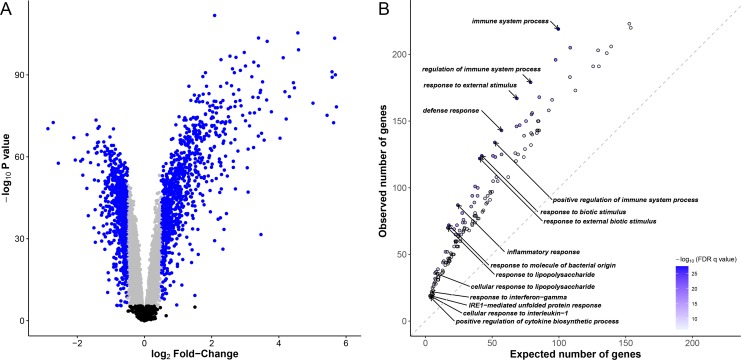
Identification of differentially expressed genes and functional characterization of immune responses to M. leprae sonicate.(A) Volcano plot showing differentially expressed genes after stimulation of whole-blood cells with M. leprae sonicate. The–log10
P values are plotted against the log2 FC. Black dots correspond to genes that are not differentially expressed, grey dots correspond to differentially expressed genes with a log2 FC < |0.5|, blue dots correspond to differentially expressed genes with a log2 |FC| > 0.5. (B) Gene ontology enrichment analysis for up-regulated genes (FDR q-value < 10−6) with a log2 FC > 0.5. Each dot corresponds to a gene ontology (GO) term. For example, the observed number of up-regulated genes belonging to the GO term “immune system process” is compared to the expected number of genes belonging to this same GO term among the genes which expression has been successfully measured. Only significant enrichments at an FDR q-value < 10−6 are included. Darker dots correspond to larger -log10(FDR q-values). The 10 GO terms displaying the largest -log10(FDR q-values) and the 5 GO terms displaying the highest enrichments are labelled. Of note, there is no gene ontology enrichment regarding down-regulated genes at this threshold.